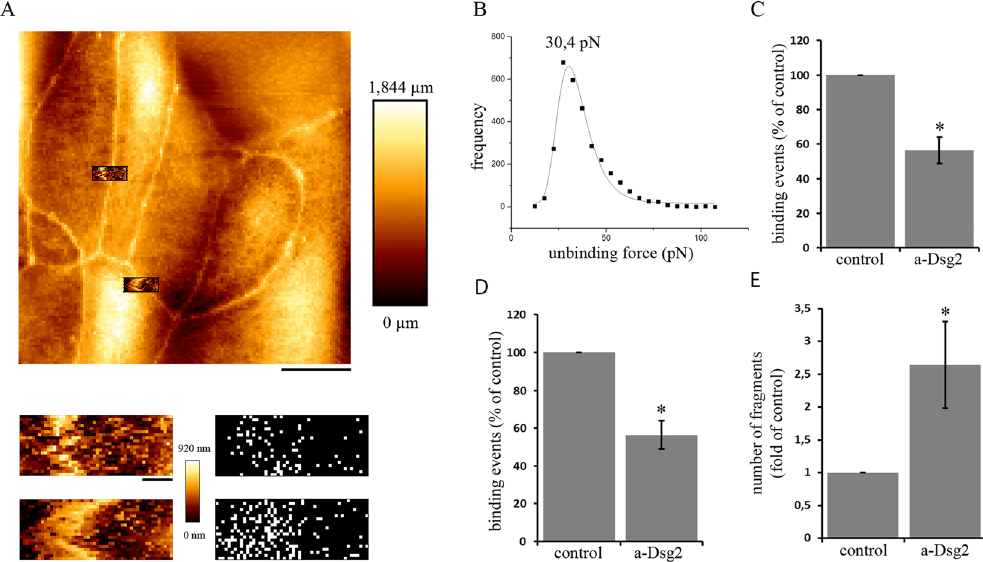
Figure 2. Dsg2-specific binding events can be detected on the surface of enterocytes. ( A ) Dsg2 force measurements were performed on living DLD1 cells at 37 °C. Cell topography was imaged to select specific areas at cell borders (upper panel). Force measurements revealed binding events along the cell border (lower panel) Bar, 10 µ m (upper panel), 1 µ m (lower panels). ( B ) Peak fit analysis of unbinding force resulted in a distribution-peak of 30,4 pN. ( C ) Application of a Dsg2-specific antibody significantly reduced the amount of binding events on living DLD1 cells as well as ( D ) in a cell-free setup (shown are means ± SE, n = 3, * p < 0,05).